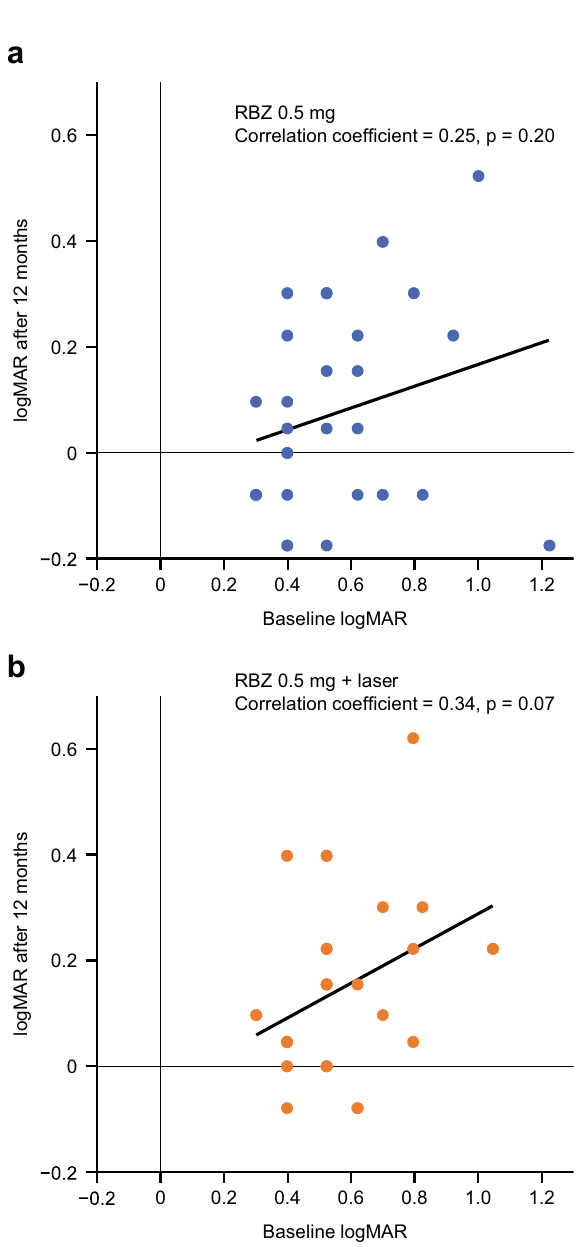
Figure 3. Correlation between visual acuity scores before the start of treatment and at Month 12. ( a ) Ranibizumab 0.5 mg monotherapy. ( b ) Ranibizumab 0.5 mg plus laser. logMAR logarithm of the minimum angle of resolution, RBZ